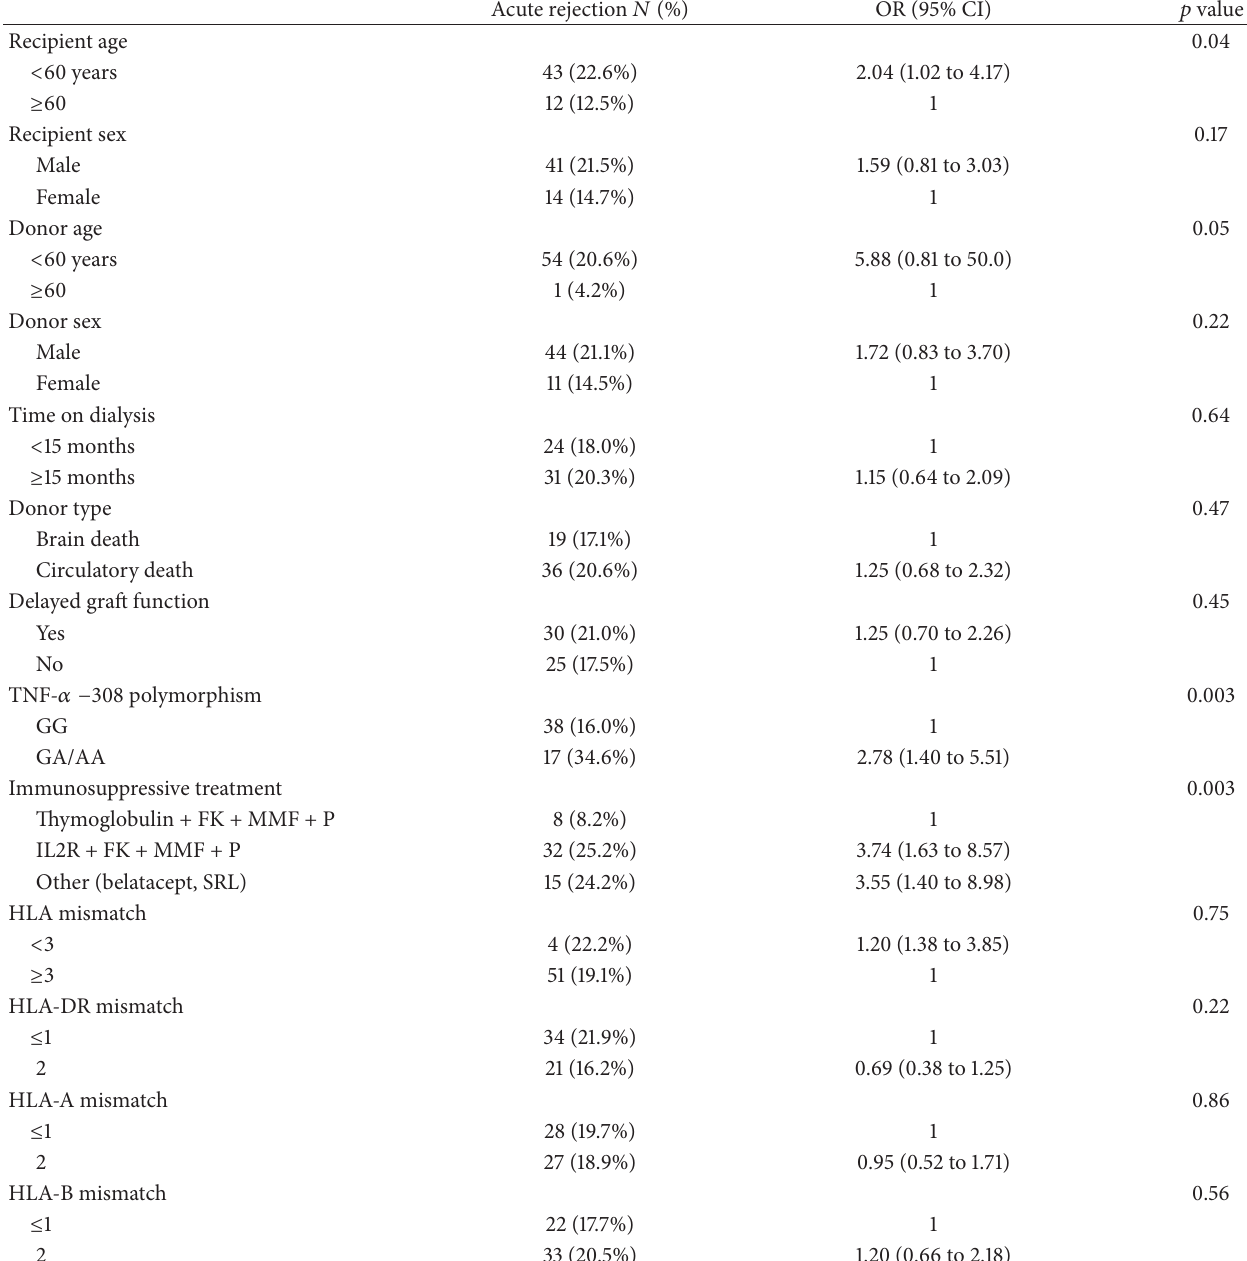
Table 2: Univariate analysis for acute rejection in the discovery cohort ( 𝑛 = 286